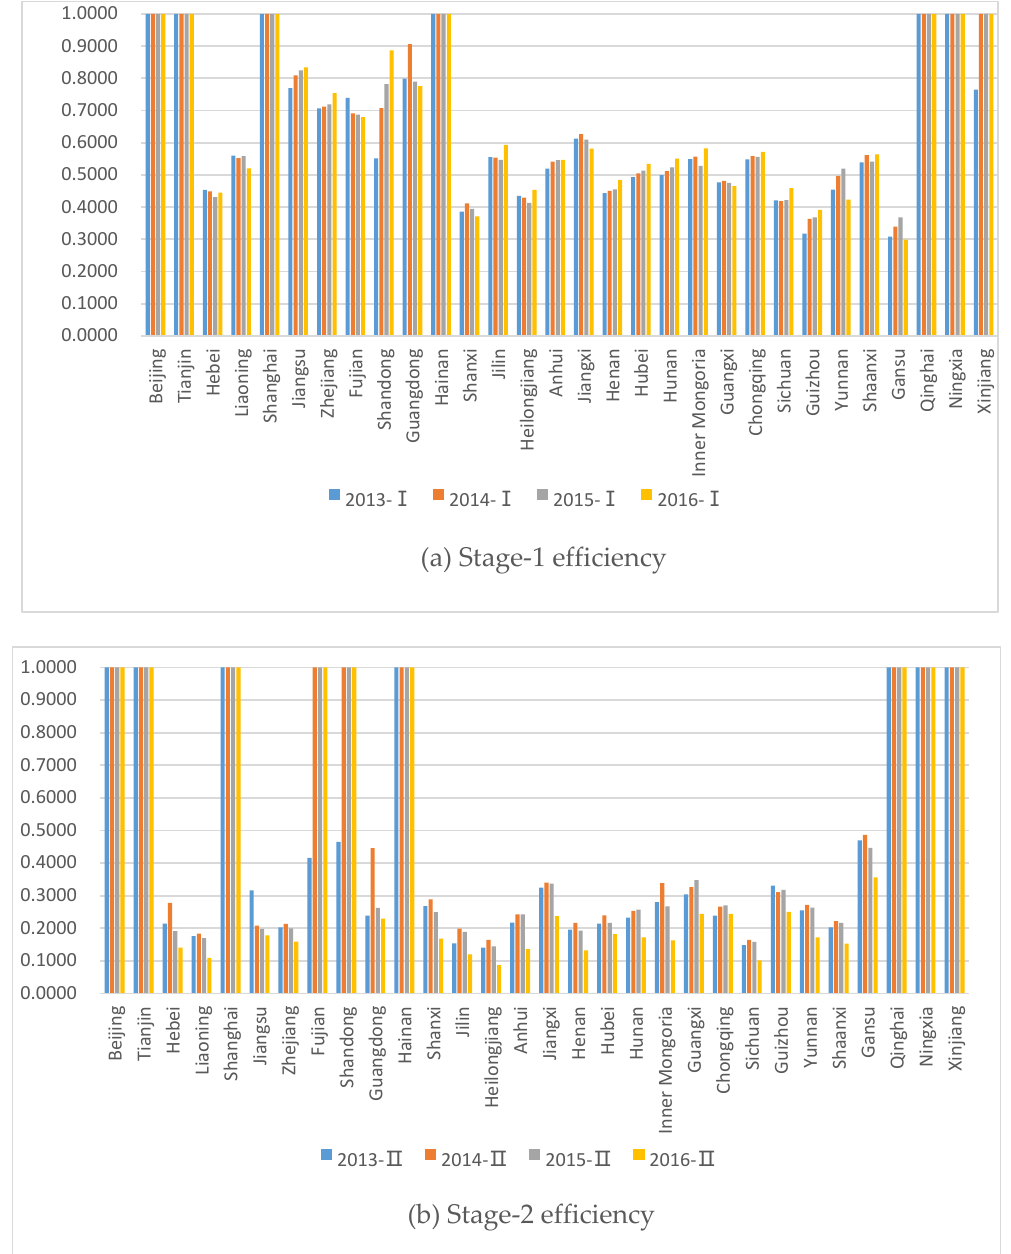
Figure 4. The efficiency of both stages by province during 2013–2016.(a) The efficiency of Stage 1. Figure 4. The e ffi ciency of both stages by province during 2013–2016. ( a ) The e ffi ciency of Stage 1. (b) The efficiency of Stage 2 ( b ) The e ffi ciency of Stage